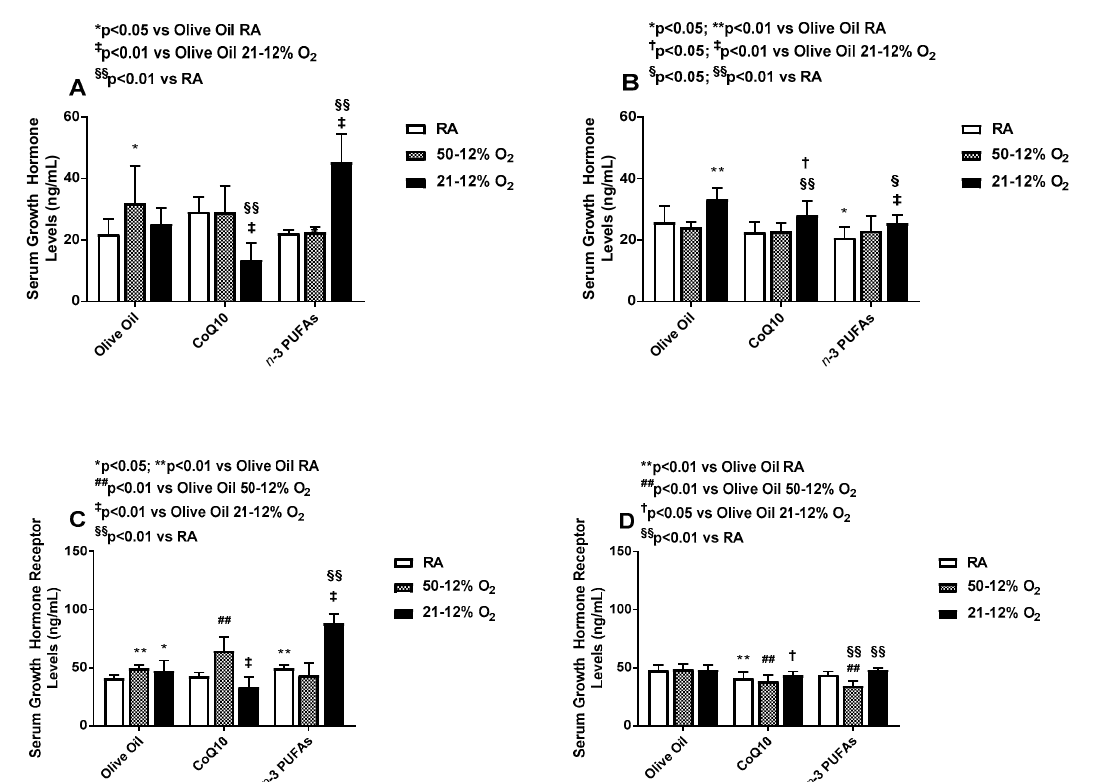
Figure 3. Effects of neonatal IH with Co-Q10 or n -3 PUFA supplementation on serum growth hormone panels ( A , B ) and growth hormone receptor panels ( C , D ) levels. Groups are as described in Figure 2. Data are expressed as mean ± SD ( n = 8 samples/group).